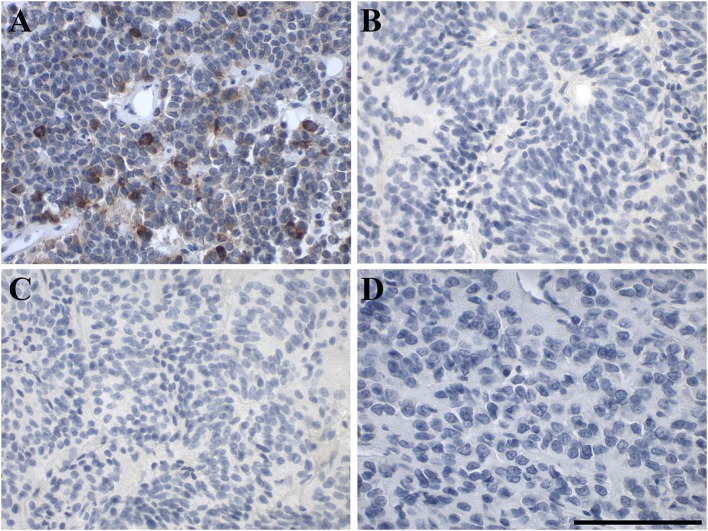
Representative images of immunohistochemical staining of in human pituitary adenoma. (A) GAL (case 7), (B) GAL1-R (case 5), (C) GAL2-R (case 5), and (D) GAL3-R (case 8). [scale bar: 100 μm].